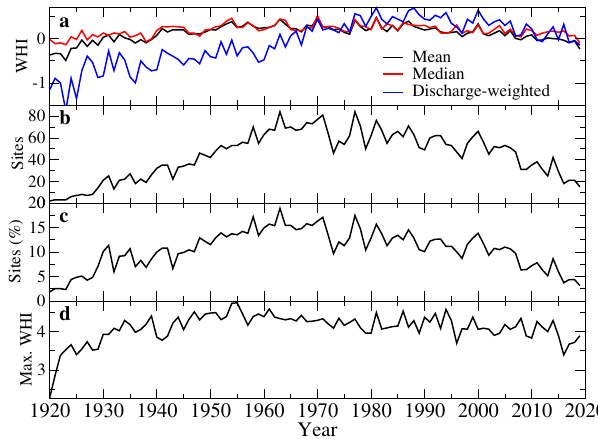
Fig. 3 Temporal evolution of WHI metrics for 500 sites across the USA and Canada, 1920 – 2019. The ( a ) annual mean, median and discharge- weighted WHI values for up to 500 sites in the USA and Canada, the ( b ) number and ( c ) percentage of available sites ranking in the top decile of all WHI values, and the ( d ) annual maximum WHI values, 1920 –